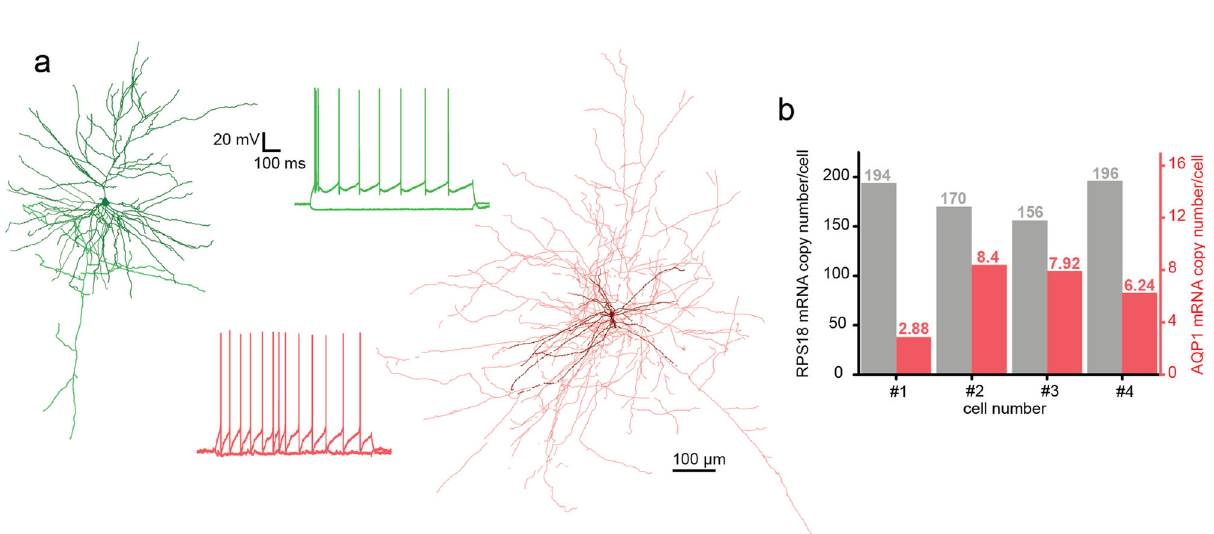
Fig. 6 Electrophysiological properties of the cells patched by DIGAP. a Main electrophysiological parameters from the successful automatic patch clamp recordings. The box plots show the series resistance ( R s , left panel), the membrane resistance ( R m , middle panel), and the resting membrane potential (right panel) of all successful measurements ( n = 47 for rat and n = 41 for human samples). The boxes show the median, 25 and 75 percentiles, and min/ max values, and the whiskers are 1.5 interquartile ranges. b Different cell types are identi fi ed according to fi ring features: pyr pyramidal cell, bAD burst adapting, cNAC continuous non-accommodating, cSTUT continuous stuttering, bSTUT burst stuttering, dSTUT delayed stuttering, cAD continuous adapting, dNAC delayed non-accomodating. c Individual neurons ’ action potential half-widths are presented as a function of the same neuron ’ s R m . Note the segregation of excitatory and inhibitory neuronal classes. Dataset is recorded from rodent samples (Panel c and d colors correspond to panel b ). d The proportion of recorded cell types. e – g Same plots as b – d , representing the dataset recorded in human neocortical slices. Source Data is available as a Source Data fi le.